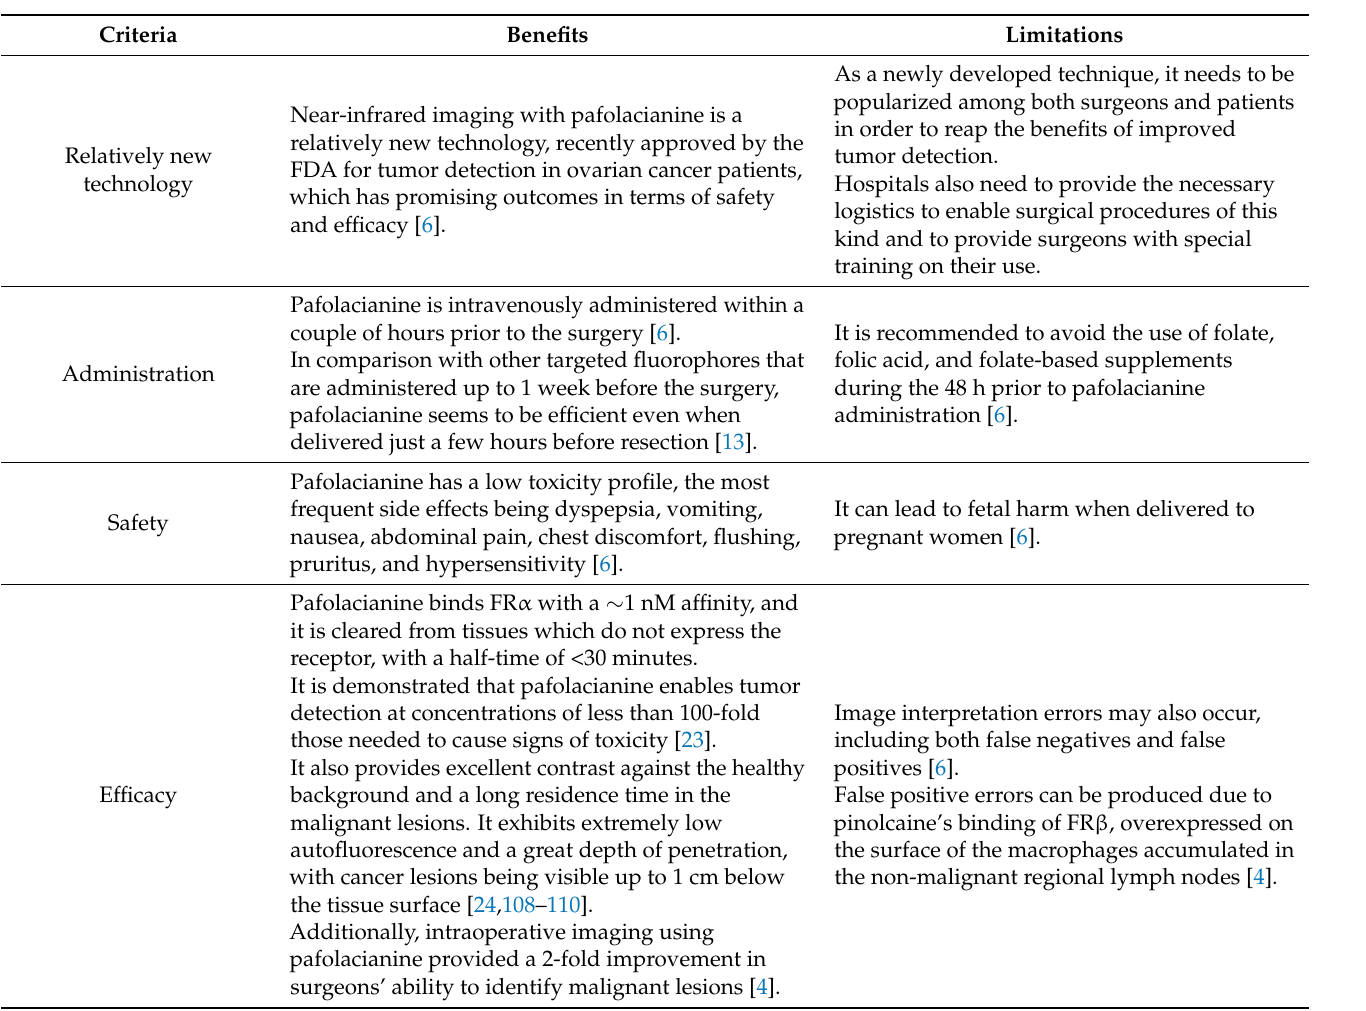
Table 3. Benefits and